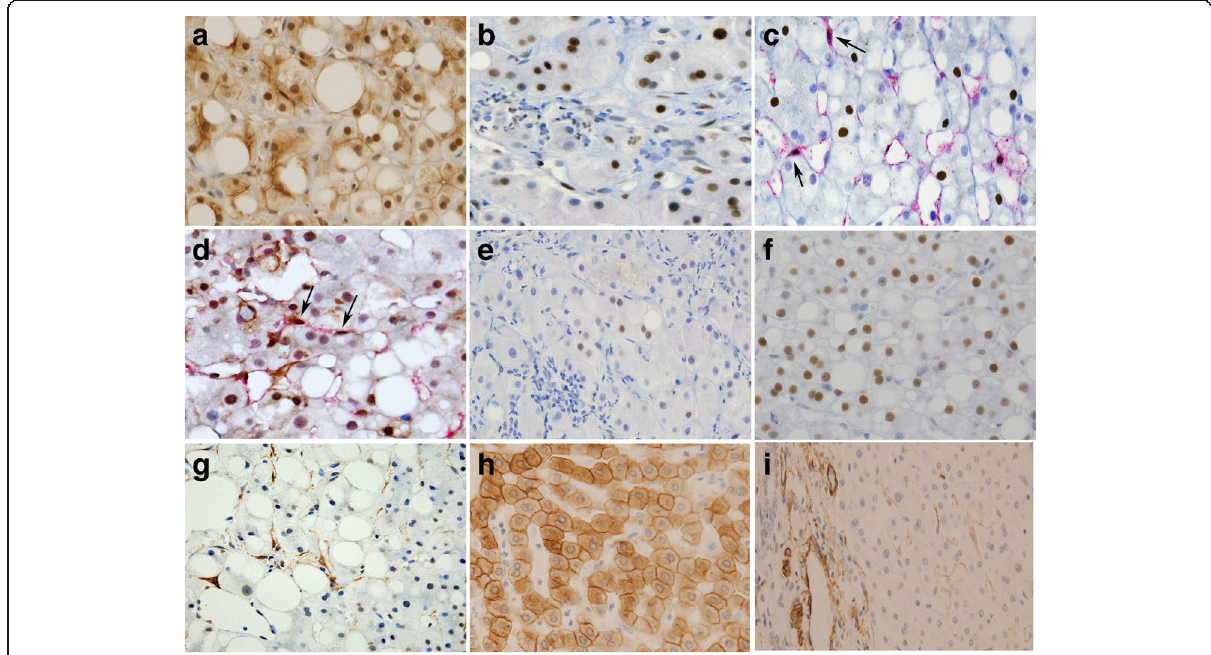
Fig. 2 Representative immunohistochemical features in hepatic steatosis ( a-g ) and the control group ( h-i ). ( a) Nuclear and/or weak cytoplasmic and membranous expression of mammalian target of rapamycin (mTOR). ( b ) Nuclear staining of phosphorylated signal transducer and activator of transcription-3 (pSTAT3) in hepatocytes. ( c ) Double staining of pSTAT3 (nucleus) and α -smooth muscle actin (cytoplasm, red color) in hepatic stellate cells (arrows). ( d ) Double staining of extracellular signal-regulated kinase (pERK) (nucleus) and α -smooth muscle actin (cytoplasm, red color) in hepatic stellate cells (arrows). ( e ) Focal expression of estrogen-receptor α in hepatocyte nuclei. (f ) Diffuse expression of estrogen-receptor α . ( g ) α -smooth muscle actin-positive cytoplasm in hepatic stellate cells. ( h ) Cytoplasmic and membranous staining of mTOR in non-neoplastic hepatocytes in a control sample. ( i ) Inconspicuous staining of α -smooth muscle actin (inactive hepatic stellate cells; center of figure) in a control sample, while strong positive staining in vessel walls as an internal positive control (left side of figure)